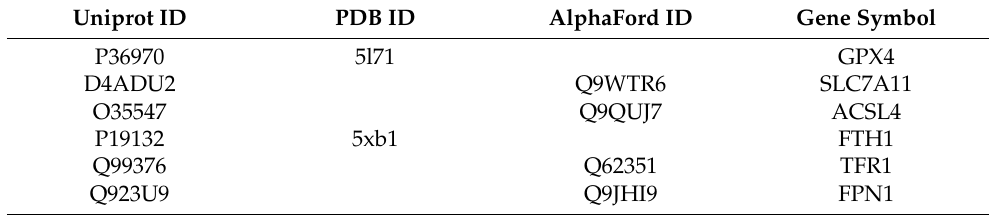
Table 1. Potential targets ID.